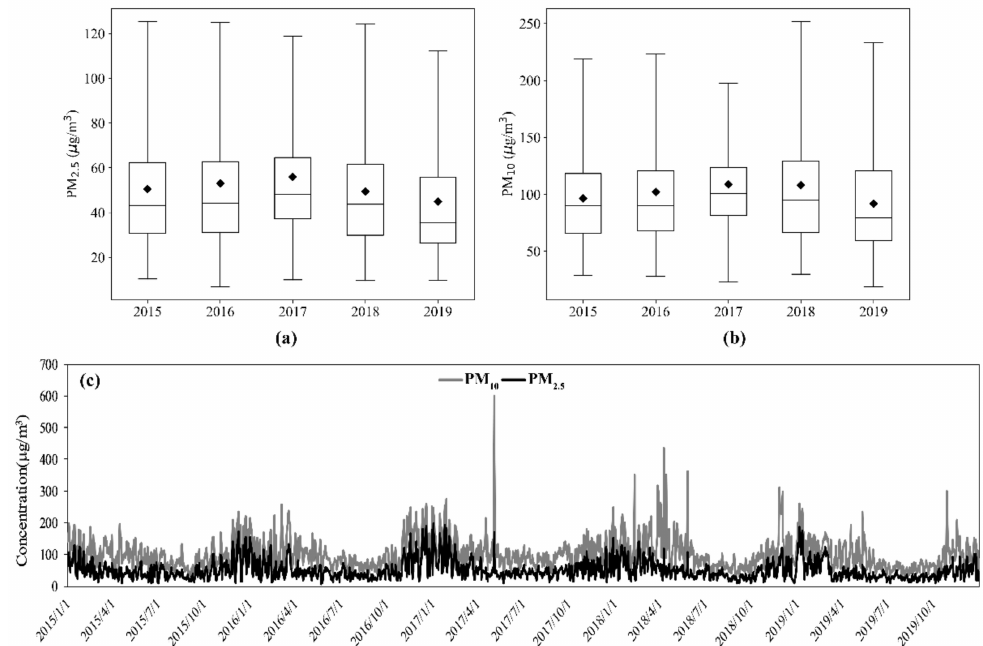
Figure 2. Temporal variation of PM concentrations in the study area from 2015 to 2019: ( a ) Annual variation of PM 2.5 ; ( b ) annual variation of PM 10 ; ( c ) five-year time series of PM 2.5 and PM 10